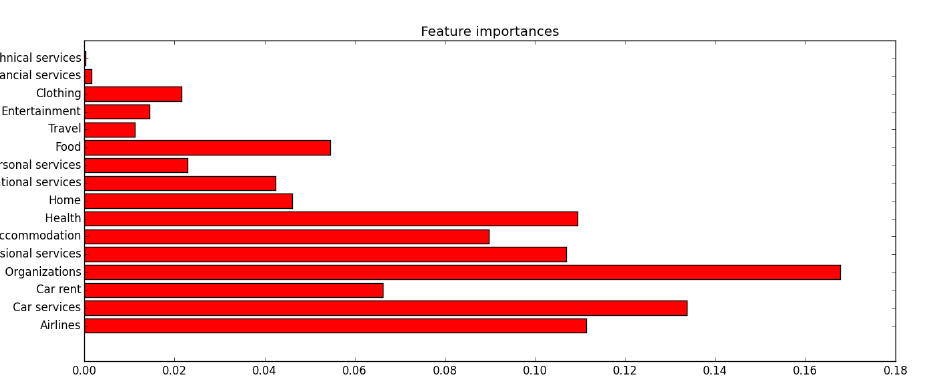
Figure 1. Feature importance plot obtained after applying of Random Forest classifier. The y axes labels are the Merchant Category